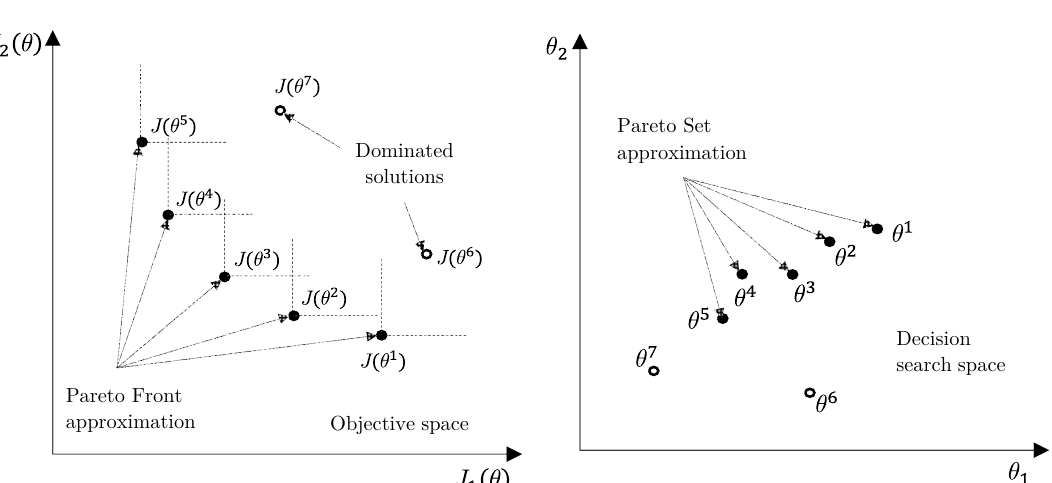
Figure 3. Pareto dominance, Pareto Front and Pareto set in a bidimensional case. There are no solution vectors dominating θ 1 ,..., θ 5 so these solutions are the approximation of the Pareto Set and their corresponding objective vectors J ( θ 1 ) ,..., J ( θ 5 ) are the approximation of the Pareto Front.